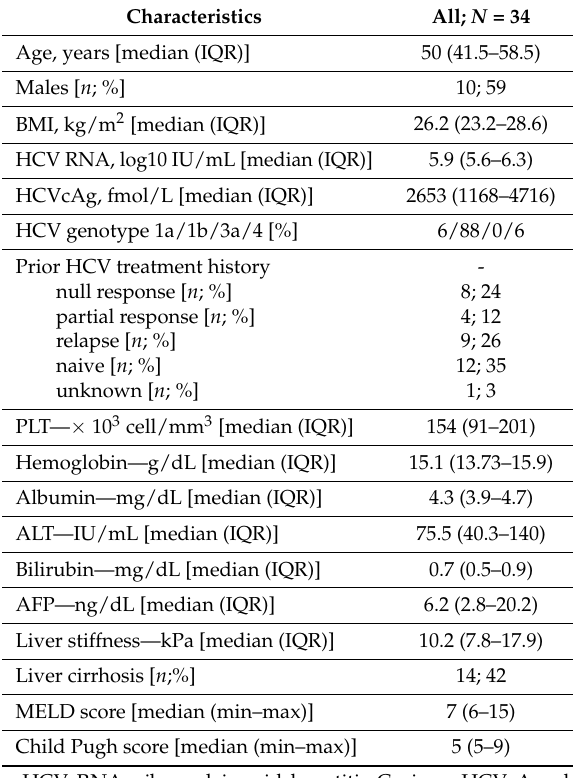
Table 1. Baseline